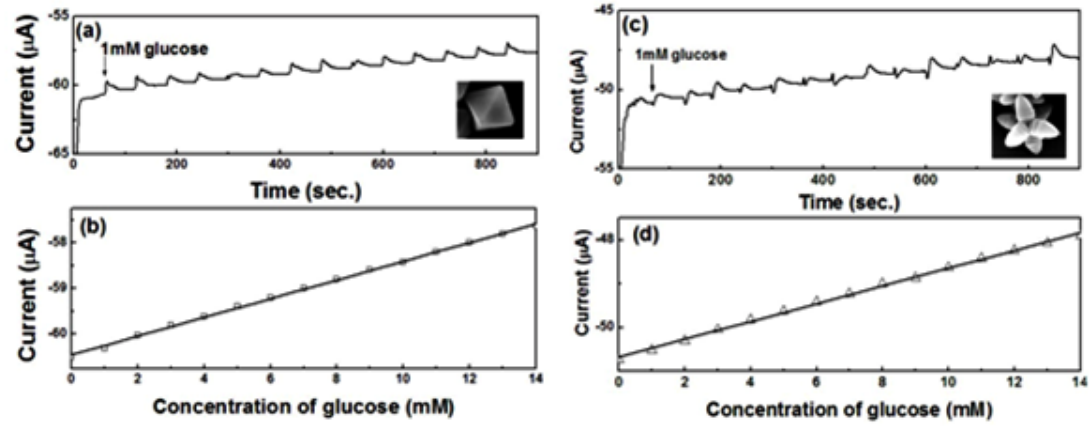
Figure 8. ( a )/( c ) Amperometric responses and ( b )/( d ) calibration plots (current vs . concentration of glucose) with linear regression analysis of octahedral ( a , c ) and hexapod ( b , d ) Cu O-based electrodes in 0.1 M PBS containing 5 mM [Fe(CN) 2 potential of 50 mV with successive additions of 1 mM